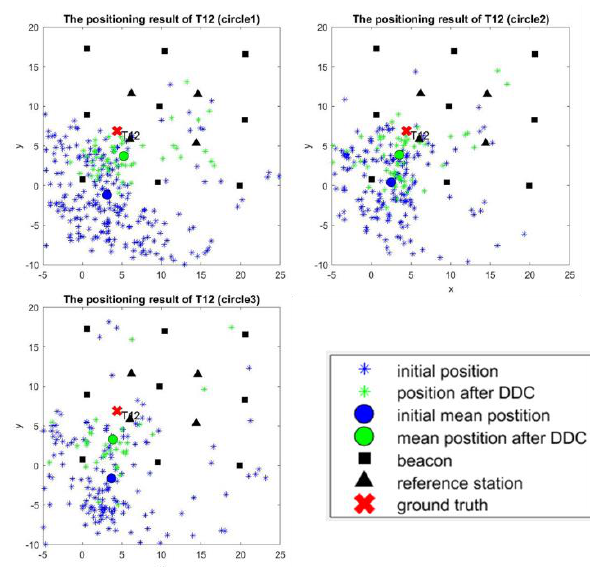
Figure 7. The BLE positioning results of participant 1